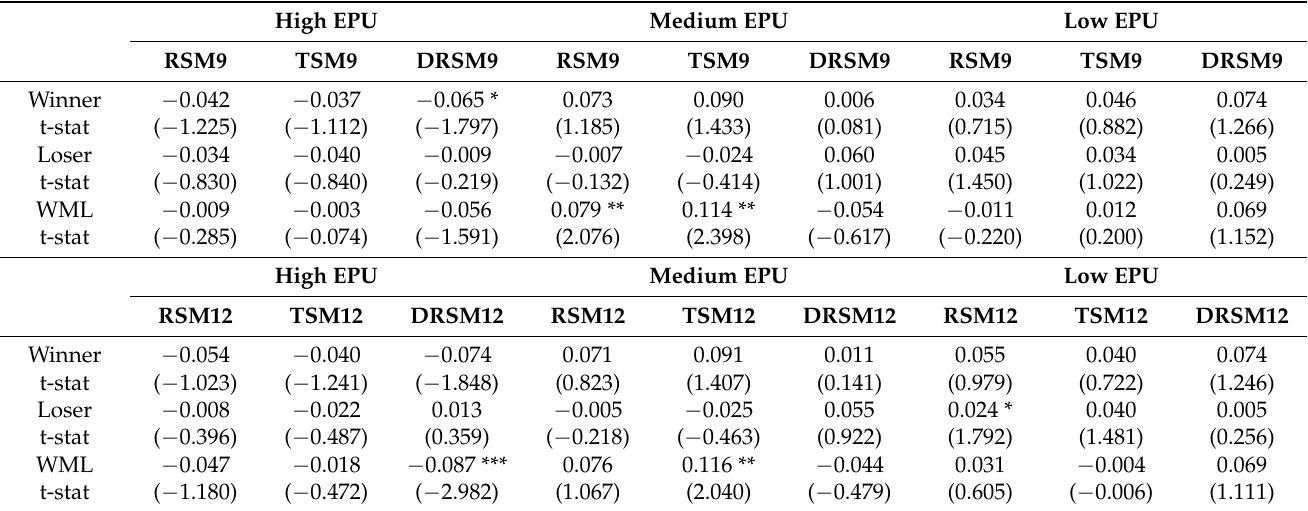
Table 6. Effect of high, medium, and low EPU stages on momentum returns in the Chinese stock market. *** denotes significant at 0.01 level, ** denotes 0.05 significance level, and * represents significant at 0.1 level,